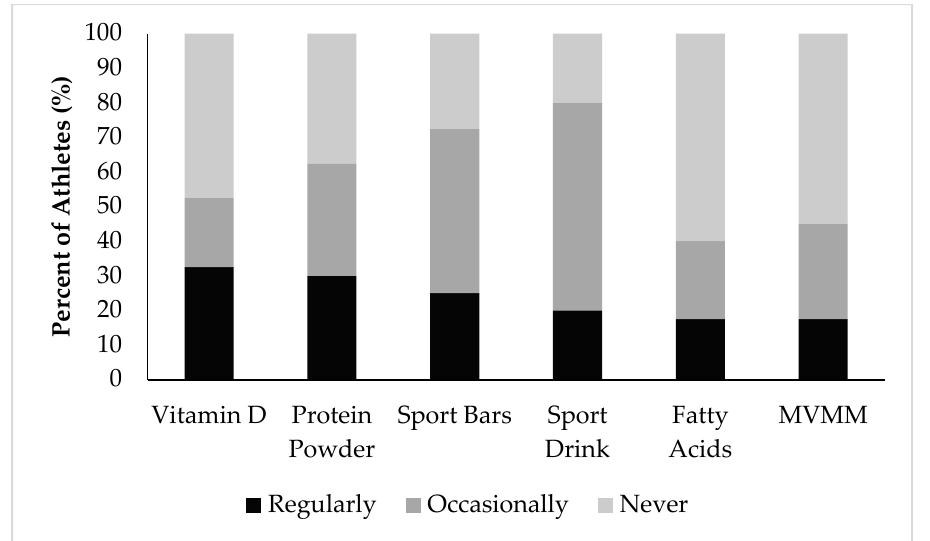
Figure 1. Dietary supplements commonly consumed by Paralympic athletes. Sport bars included carbohydrate and protein based bars designed for athletes. Sport drinks included electrolyte/carbohydrate formulas and electrolyte formulas. MVMM, multivitamin multimineral formulations.